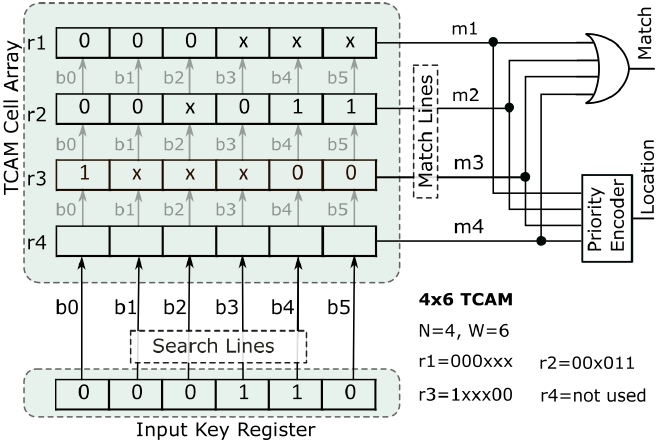
Figure 1. A conceptual view of a 4 × 6 ASIC-style Ternary Content Addressable Memory